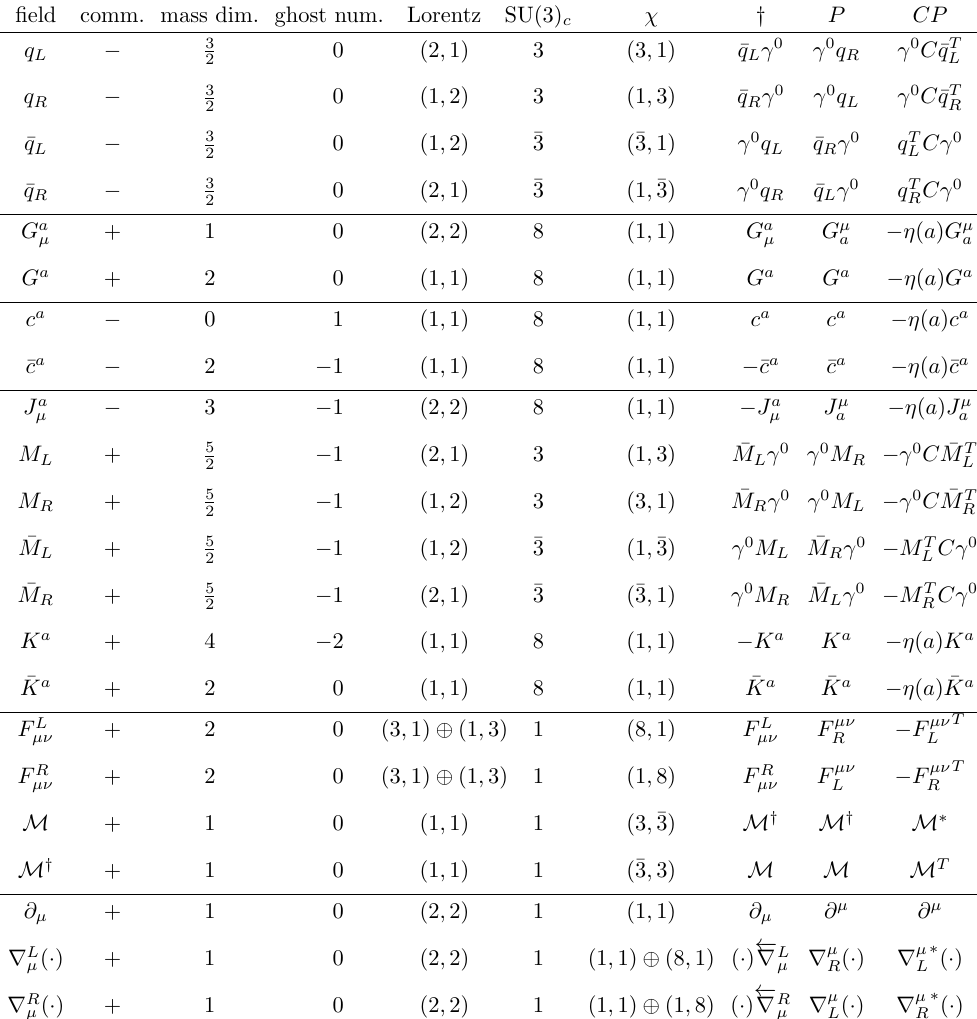
Table 4 . Properties of dynamical (cid:12)elds, sources, spurions, and derivative operators. For simplicity, additional arbitrary phases in P - and CP -conjugation are neglected. (cid:17) ( a ) is de(cid:12)ned in (A.6). Note that we de(cid:12)ne the complex conjugate of the product of Grassmann variables c